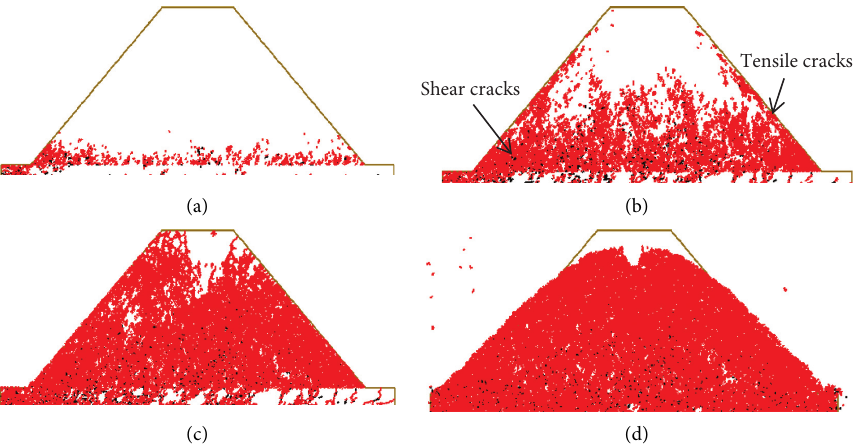
Figure 7: Crack development process in the slope with 5% moisture content. (a) At loading 0.1s. (b) At loading 0.3s. (c) At loading 0.5s. (d) At loading 3s.